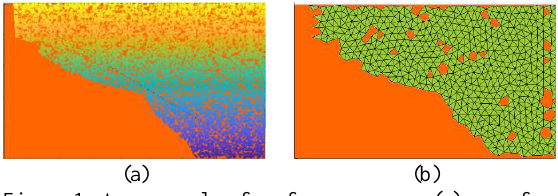
Figure 1. An example of surface coverage: (a) a surface (orange) and its corresponding point cloud; (b) a 2D alpha- shape (green), which is constructed from the projection of the point cloud on the surface, cover up 56% of the surface ( 𝑀 𝑐𝑜𝑣 = 0.56